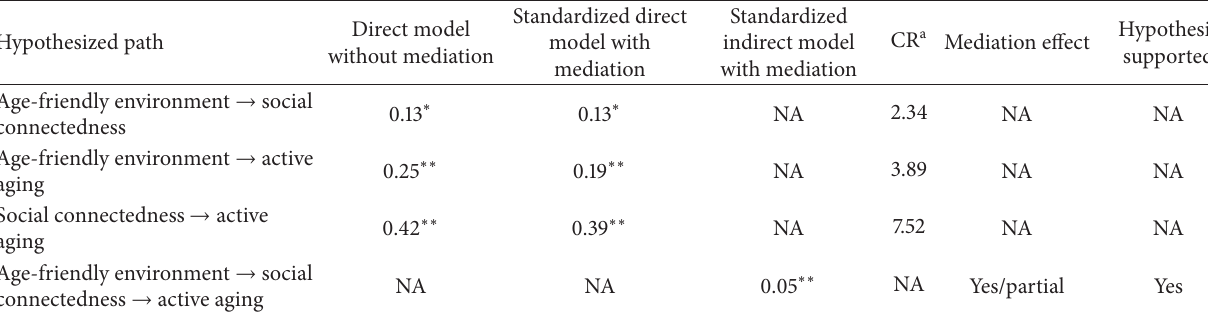
Table 7: Results of mediation effect.